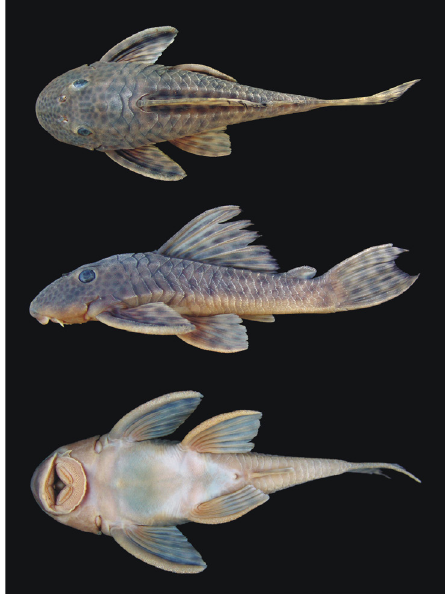
FIGURE 1 | Hypostomus hermanni , NUP 16526, topotype, 134.4 mm SL; Brazil, São Paulo State, Piracicaba, Piracicaba River, Upper Paraná River basin. Dorsal, lateral and ventral